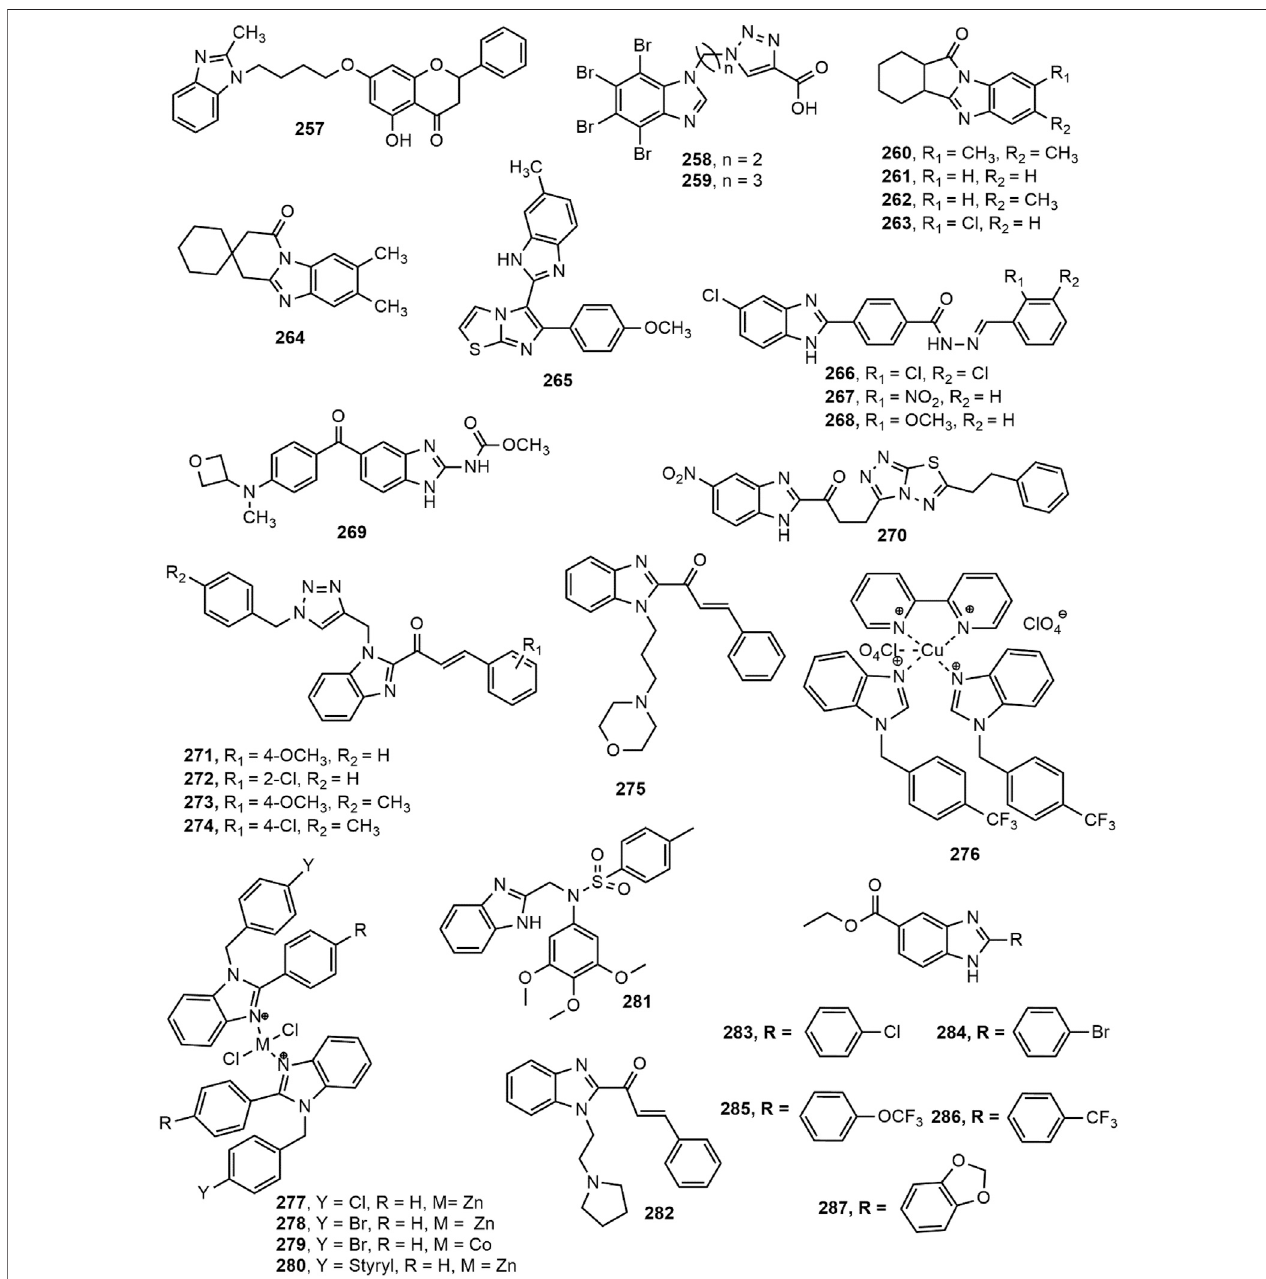
FIGURE 10 | Benzimidazole derivatives with anticancer